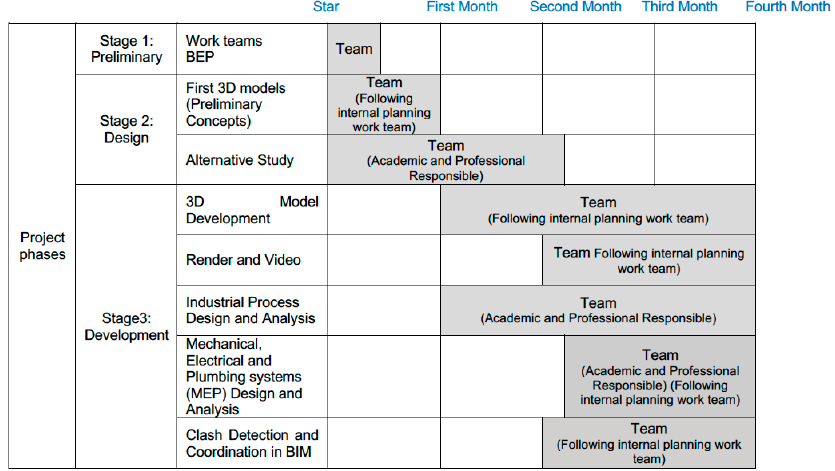
Figure 3. Schedule of project phases.